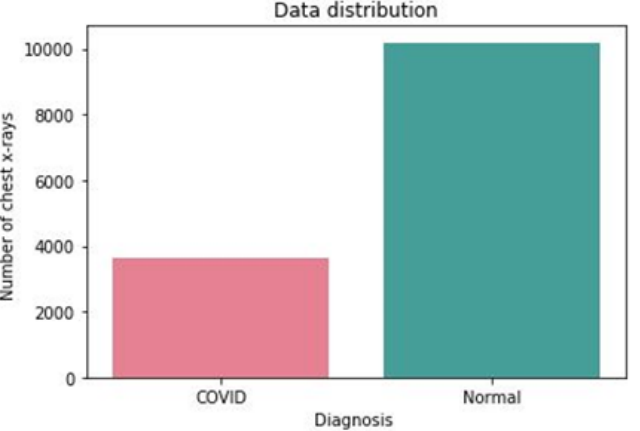
Figure 2. Distribution of the two classes in the dataset.